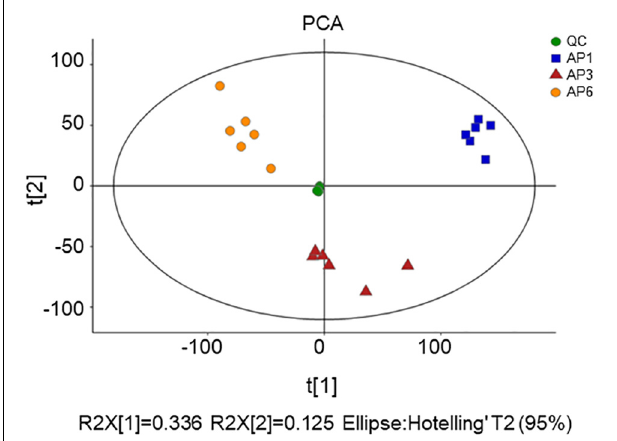
FIGURE 1 | The score plots of PCA for metabolite profiles in A. pedunculata leaves. AP1 samples were picked at the flowering stage of the plant; AP3 samples were picked at the fruit development stage; AP6 samples were picked at the fruit ripening stage; QC was quality control sample.